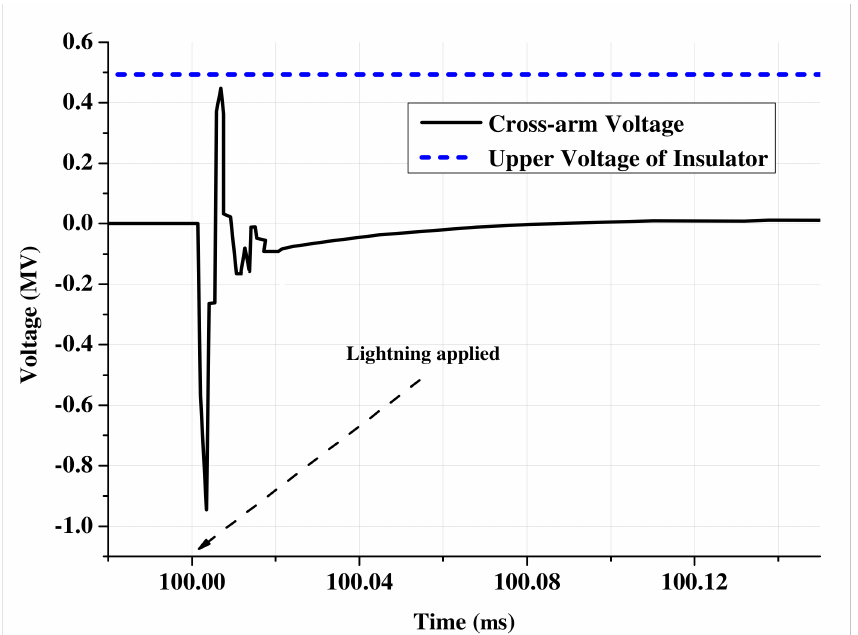
Figure 12. Voltage at tower cross-arm point and upper point of insulator with 28 kA lightning